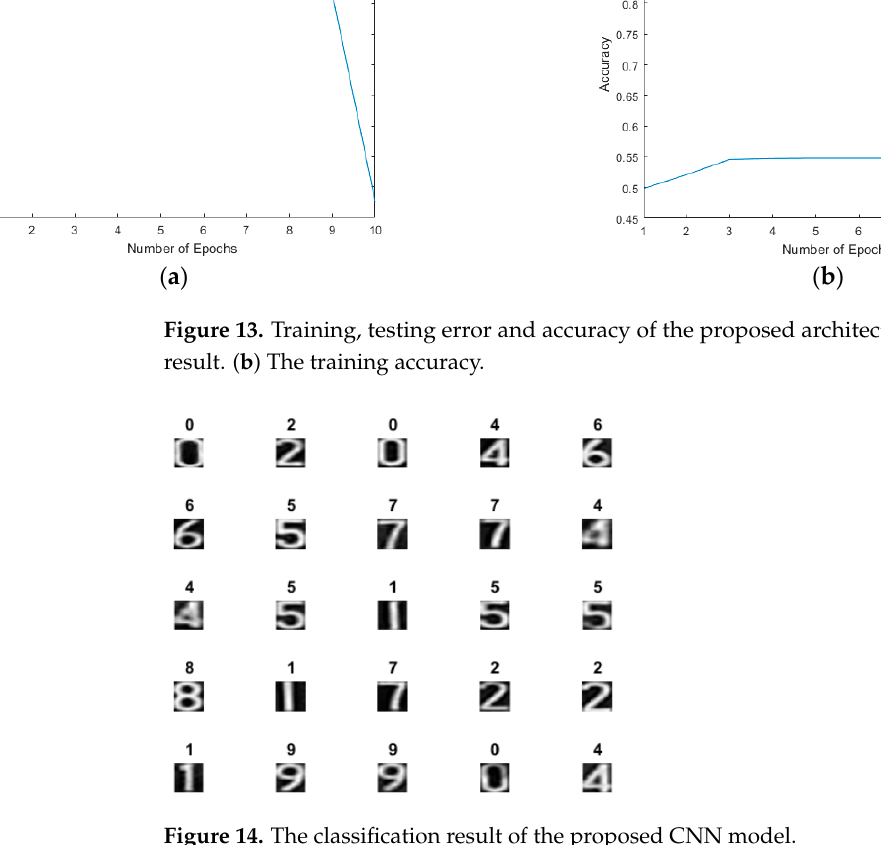
Figure 14. The classification result of the proposed CNN model.